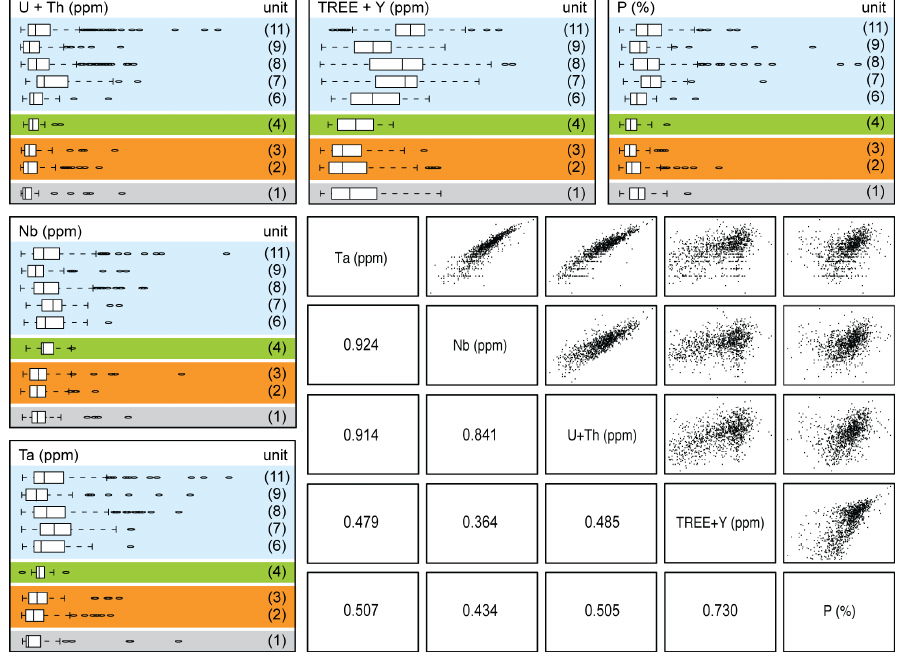
Figure 4. Correlation of selected geochemical parameters to lithological units (first row; see Table 1 for a detailed description) and to each other. The scatter diagram matrix between Ta, Nb, Th + U, Total Rare Earth Element (TREE) + Y, and P shows the Spearman rank correlation value (lower left) and the scatter diagrams in the upper right. Lithological classification is explained in detail in Table 1. Table 1. Lithological units of Epembe dyke from field observation and their genetic